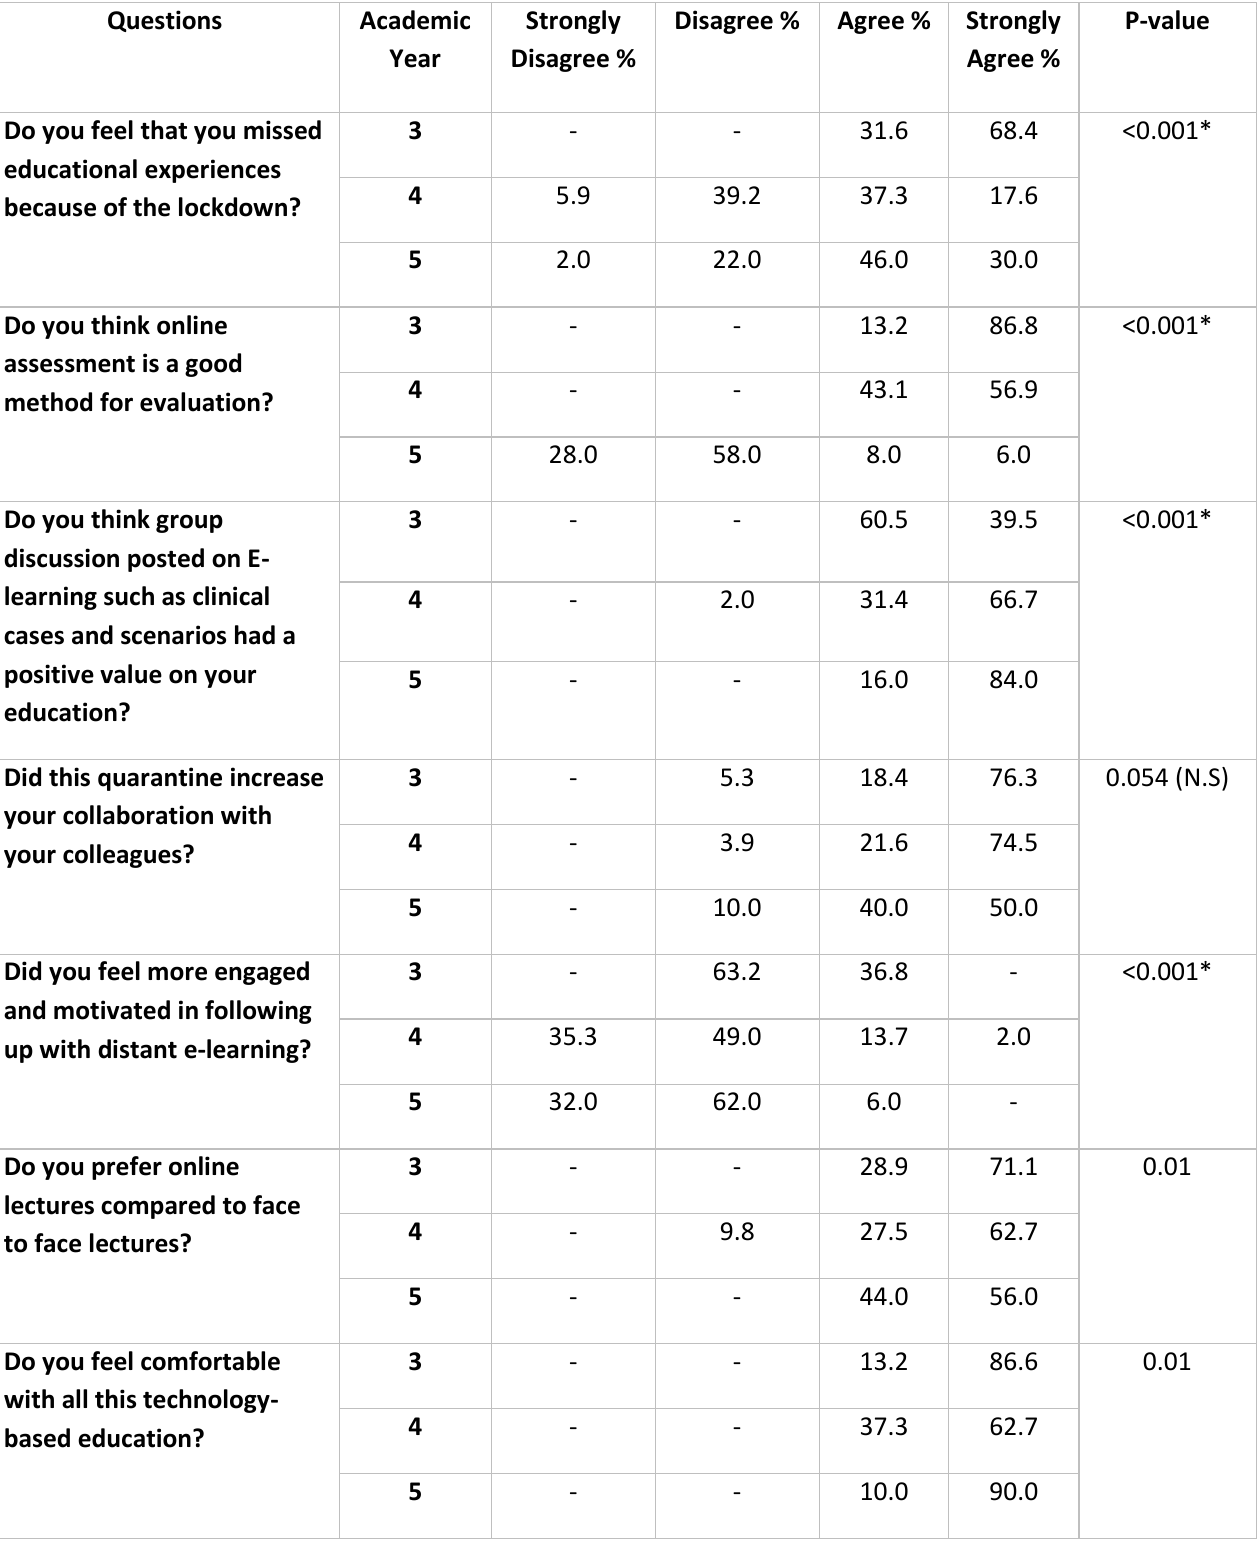
Table 2: Impact of COVID-19 on dental education among year 3,4 and 5 dental students